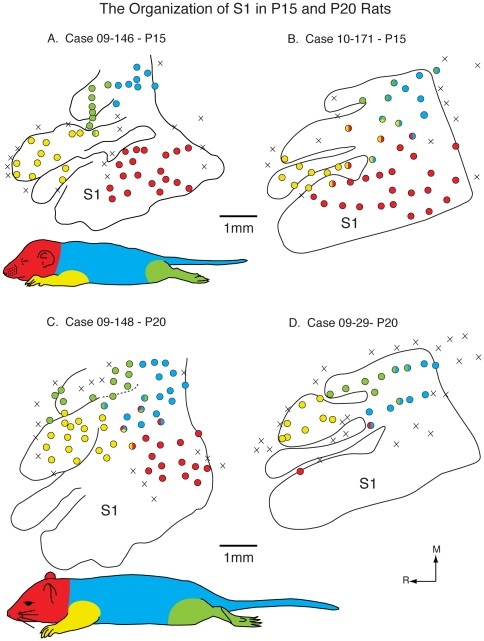
Functional S1 maps in P15 and P20 rats.Reconstructed functional maps of primary somatosensory cortex in P15 (A and B) and P20 (C and D) rats. At P15, normal somatotopy is beginning to emerge, but there is still considerable variability in map organization between individuals (compare A and B). By P20, the functional maps have an adult-like organization. Conventions as in previous figures.